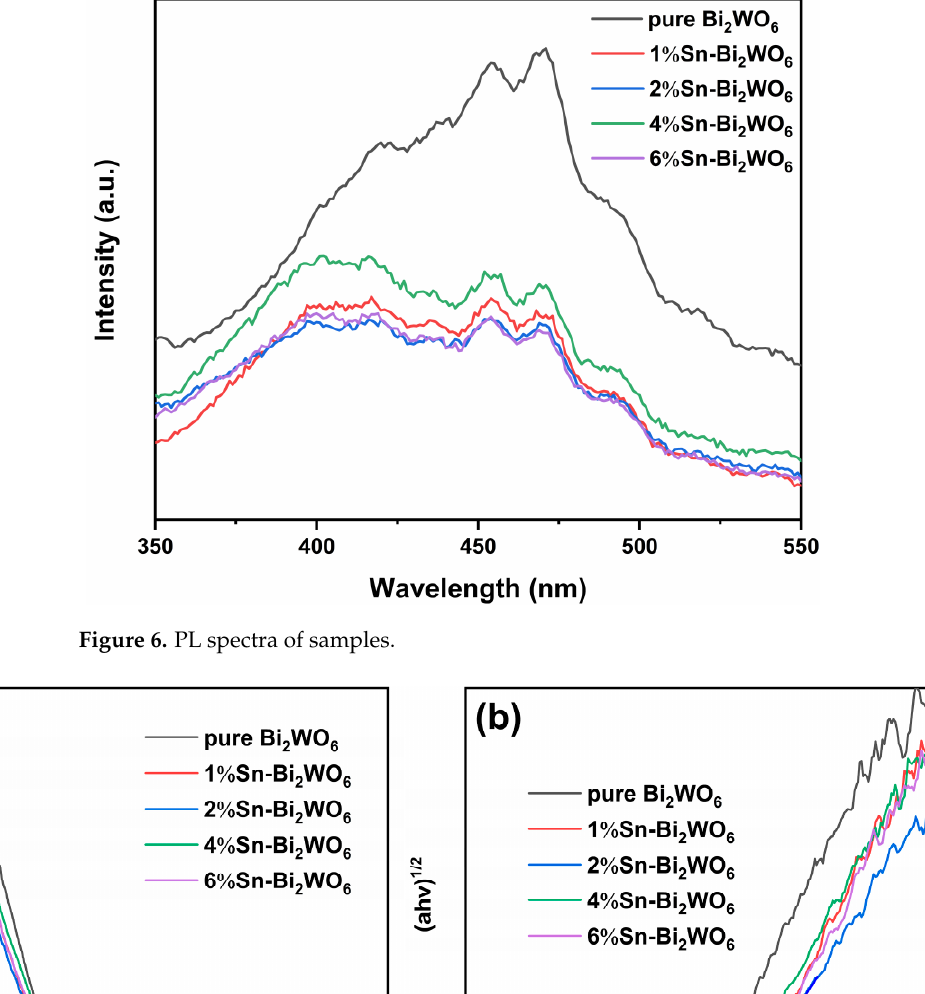
Figure 7. Diffuse reflectance spectra ( a ) and band gap energy ( b ) of samples.